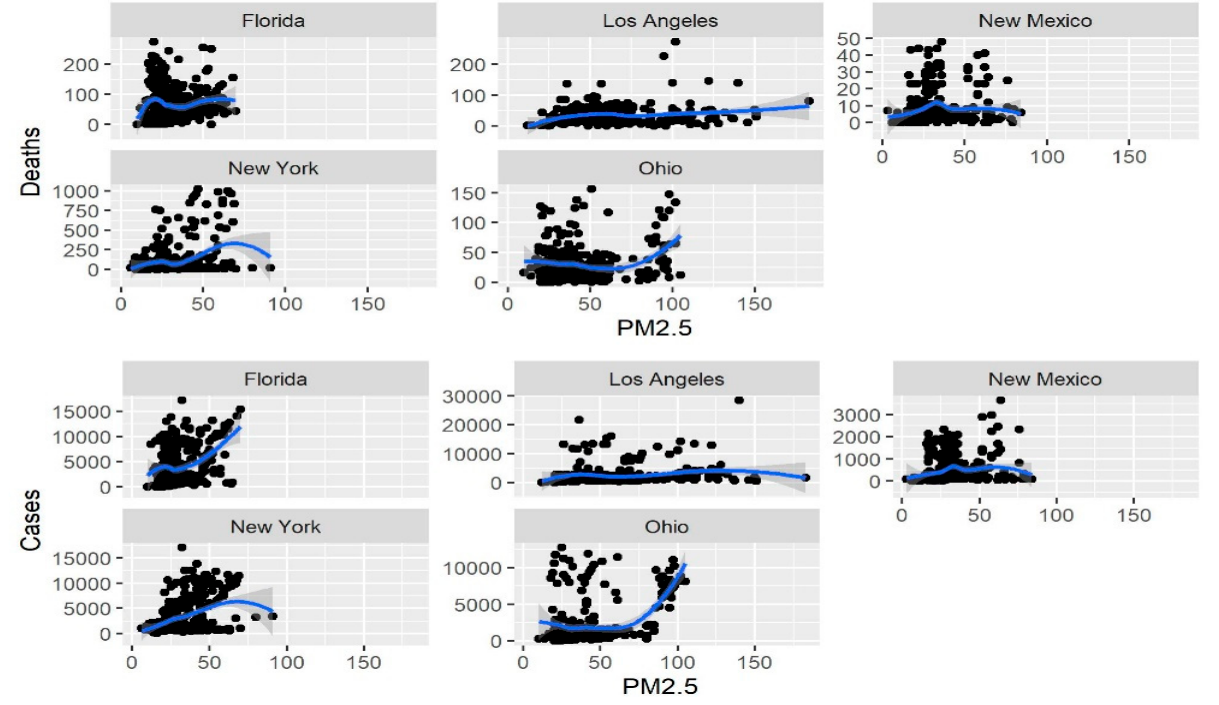
Figure 5. Relationship of PM2.5 concentration with the number of new daily cases and deaths.